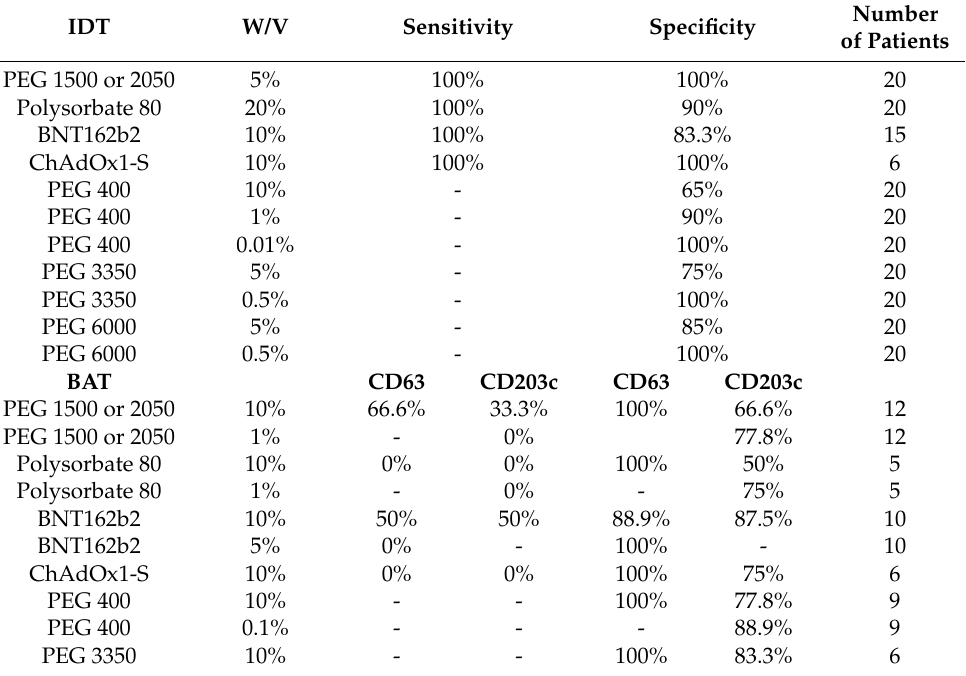
Table 3. Performance characteristics of skin testing and basophil activation testing. IDT W/V Sensitivity Specificity